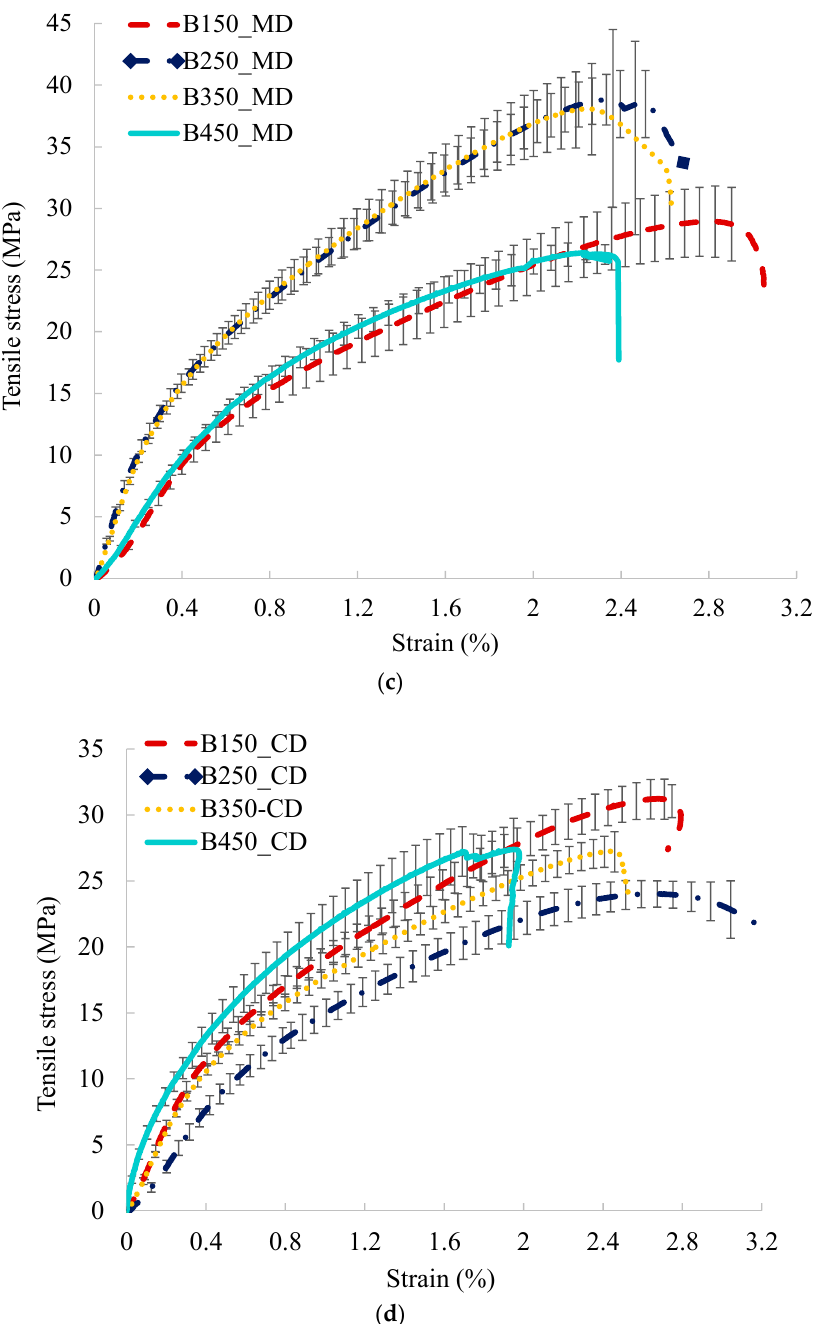
Figure 2. Tensile behaviour of nonwoven composites. ( a ) set A in MD, ( b ) set A in CD, ( c ) set B in MD (Machine direction), and ( d ) set B in CD (Cross direction). From the stress-strain curves, the tensile behaviour of nonwoven composites can be characterised by the tensile strength (denoted Smax), the strain at break, and two moduli computed, respectively, in the ranges of 0–0.3% strain (denoted E1) and 0.5–1.5% strain (denoted E2). Smax